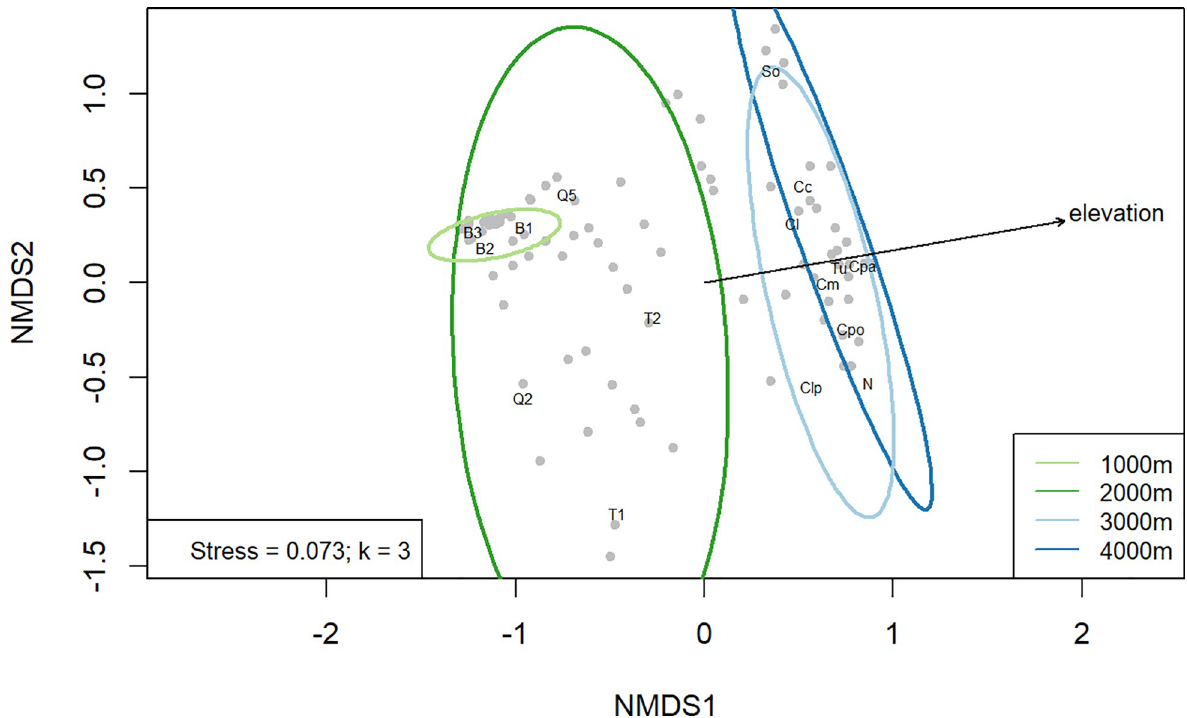
Fig 2. NMDS plot for AM fungal communities. NMDS ordination showing turnover of species composition along elevational gradient. Species scores are shown as gray dots and site scores as black labels. The ellipses around data points show the 95% confidence interval for the 1000 m (light green), 2000 m (green), 3000 m (light blue) and 4000 m (blue) sites. The 1000 m and 2000 m confidence ellipses were not overlapping with the 3000 m and 4000 m ellipses, indicating significant turnover of AMF communities from 2000 m to 3000 m. Overall effect of elevation on AMF communities is supported by PERMANOVA (F = 2.6488, p = 0.001). Overall stress of the ordination is 0.073 with 3 dimensions (k =